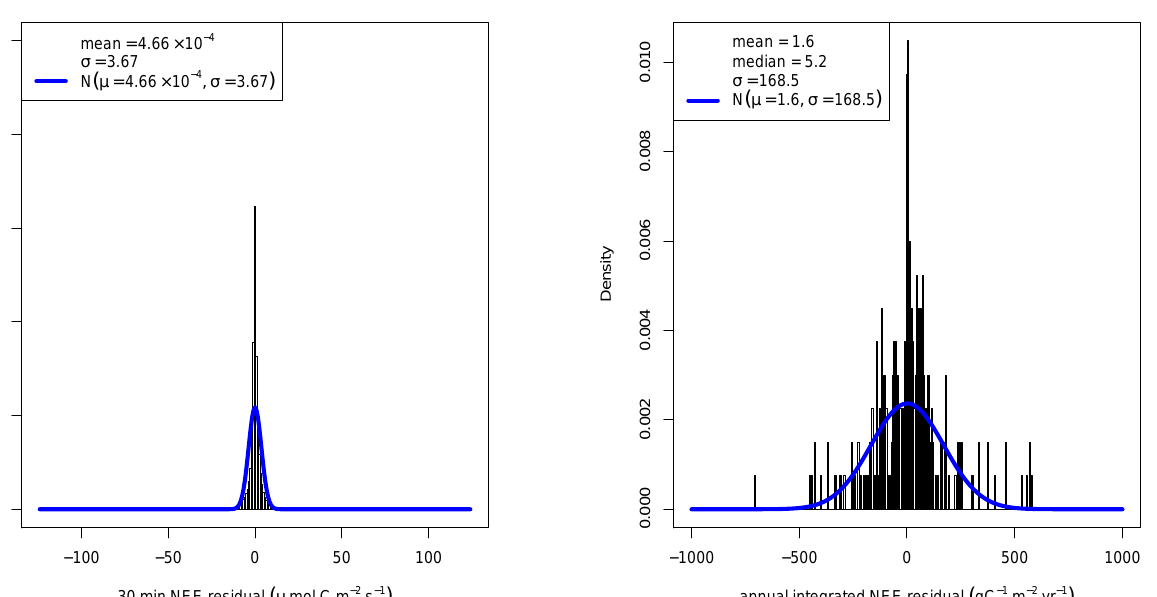
Fig. 4. Histogram of VPRM NEE residuals at eddy covariance site reporting temporal resolution (30min or 60min), PFT–all-data VPRM parameters. NEE residuals are calculated as observed NEE (non-gap-filled) minus VPRM NEE. A normal distribution proba- bility density function with the same mean and standard deviation is overlaid.